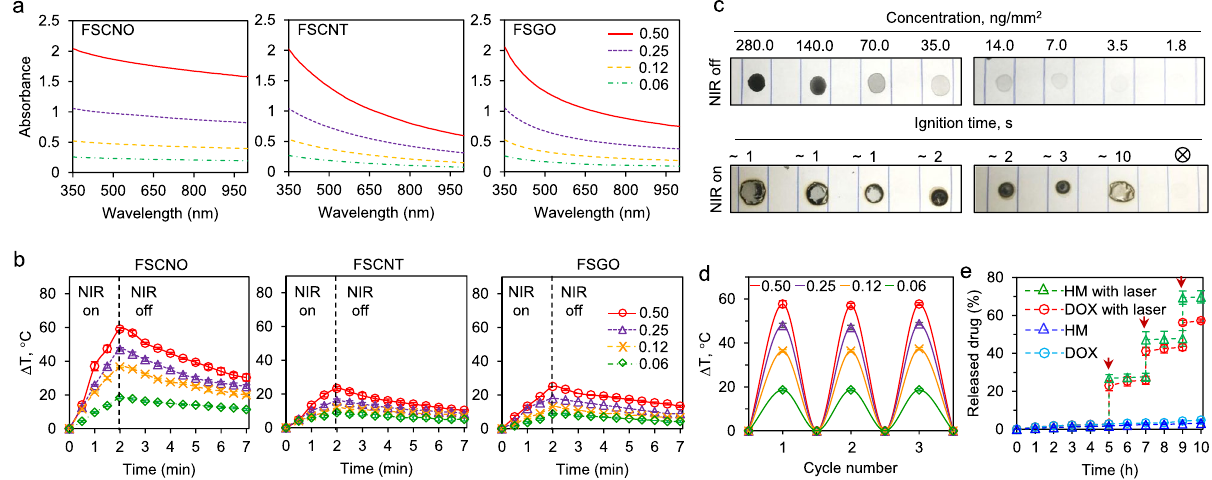
Fig. 3 Photothermal effect of FSCNO nanoparticles and controlled release of therapeutic agents. a UV-Vis absorbance of FSCNO, FSCNT, and FSGO nanoparticles in water at different concentrations (0.06, 0.12, 0.25, and 0.50 mg ml − 1 ) showing the FSCNO nanoparticles have higher absorption in the NIR region than the FSCNT and FSGO nanoparticles. b The temperature in aqueous solutions of FSCNO nanoparticles increases faster than that in the aqueous solutions of FSCNT and FSGO nanoparticles upon NIR irradiation (1.0 W cm − 2 ) for 2 min at different concentrations (0.06, 0.12, 0.25,